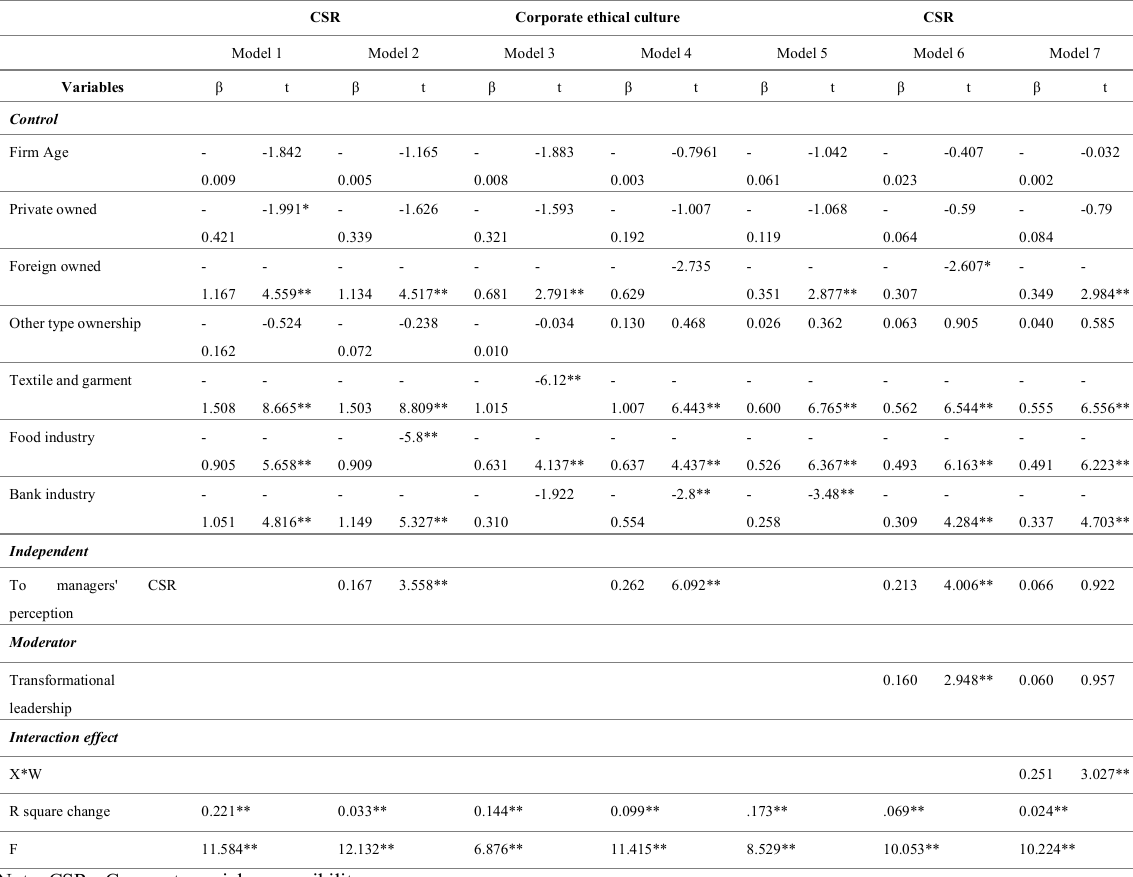
Table 2 displayed the result of hierarchical regression of CSR as dependent variable, top managers’ CSR perception as independent variable and transformational leadership as moderator. The result showed that hypothesis 1 is supported. Table 2 : Results of hierarchical